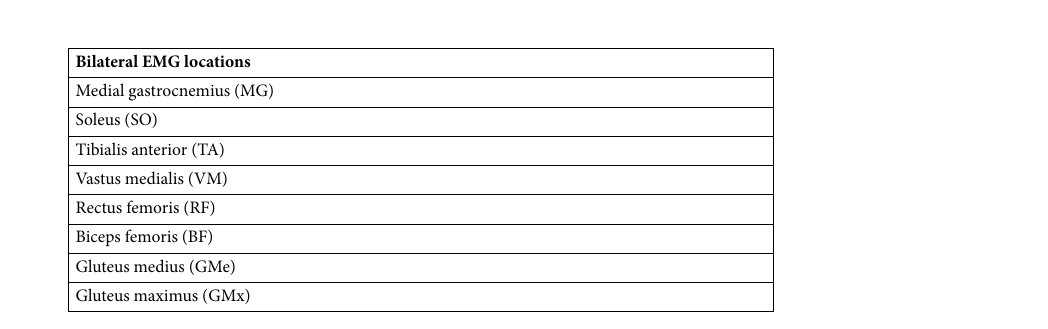
Table 2. Bilateral EMG placement